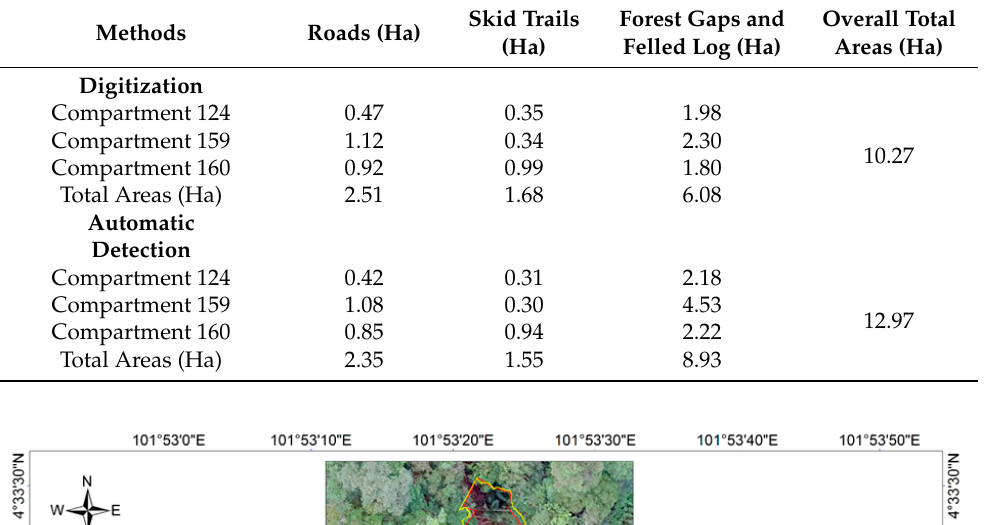
Table 8. Area of roads, skid trails and forest canopy gaps between the two approaches.